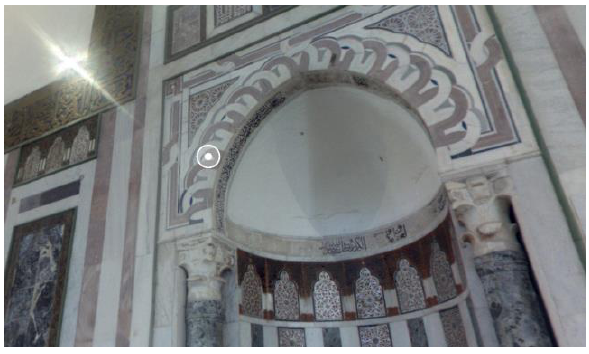
Figure 4. • Madrasa al-Jaqmaqiya – Virtual Tour Hotspot, Inlaid Marble